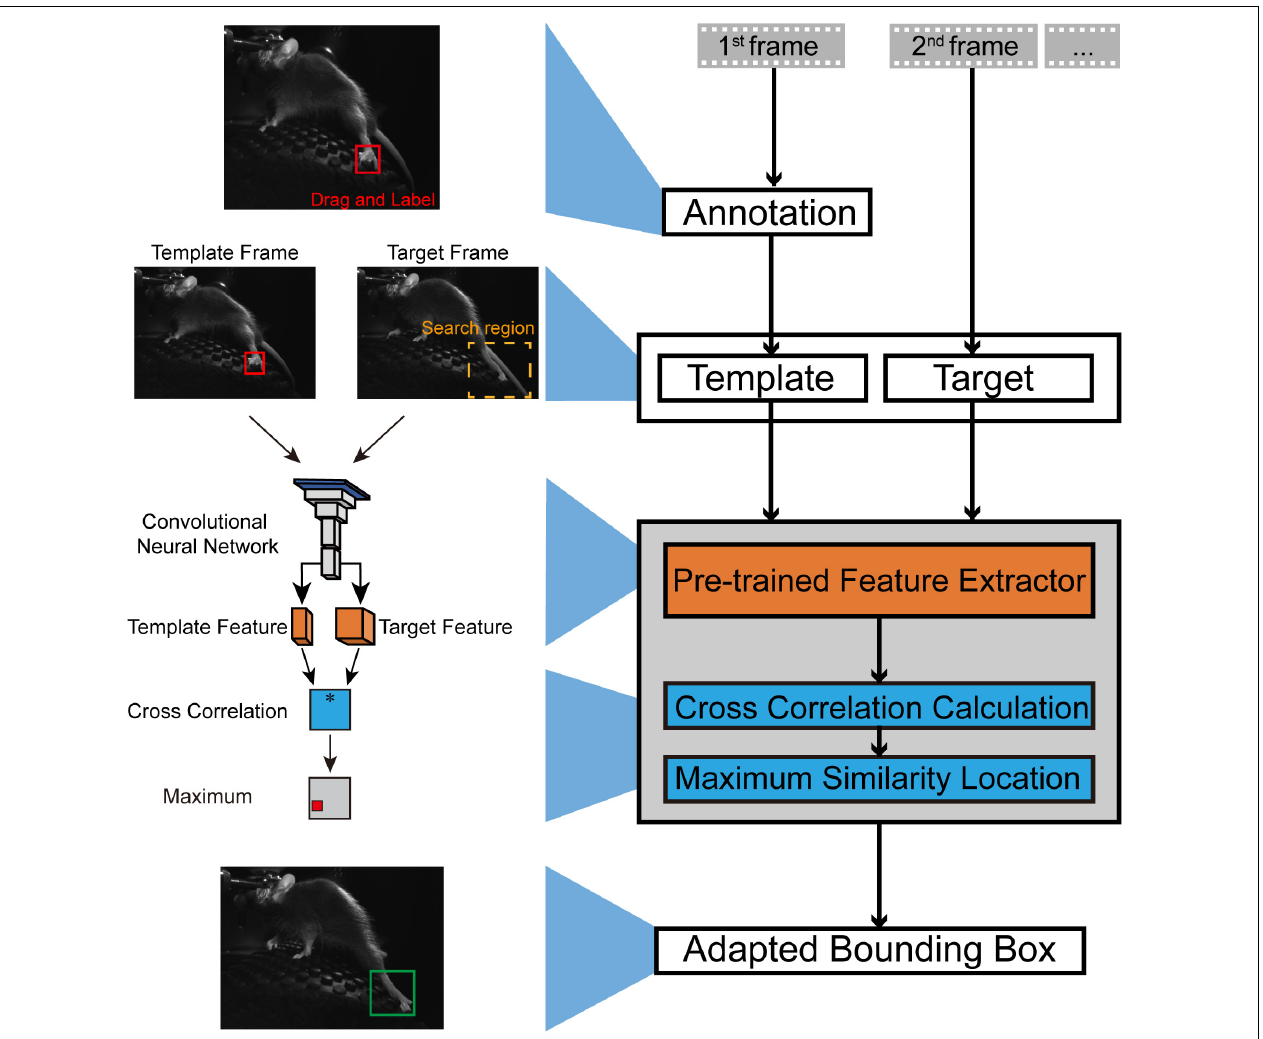
FIGURE 1 | An illustration of the workflow for SNAP-Tracker. In the typical workflow of SNAP-Tracker, users should make the only annotation at the first frame of the video by dragging a bounding box out of the tracking object, which will serve as the template for the second and other later frames. In the search region of a target frame, the image feature is extracted by the pretrained feature extractor simultaneously with the template. After comparing the cross-correlation between the template and target frame feature, the similarity metric module will select the location with maximum similarity and generate an adapted bounding box outside the tracking object. Connecting the bounding boxes of all frames in series can form the object’s trajectory. ∗ Denotes the similarity function (i.e., cross correlation) to be computed for target and template